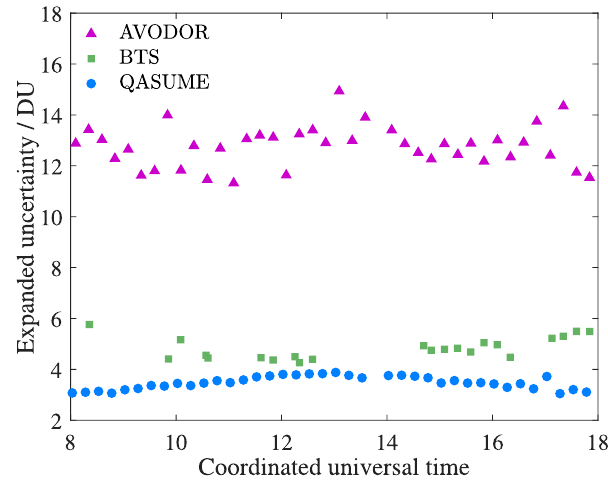
Figure 6. Total ozone columns (TOC) derived from the solar UV spectra from 300nm to 340nm with expanded uncertainty bars ( k = 2) for QASUME indicated as blue circles, BTS indicated as green squares, and AVODOR indicated as magenta triangles. The TOC measured with Brewer #183 is plotted as black crosses with grey uncertainty bars ( k = 2).